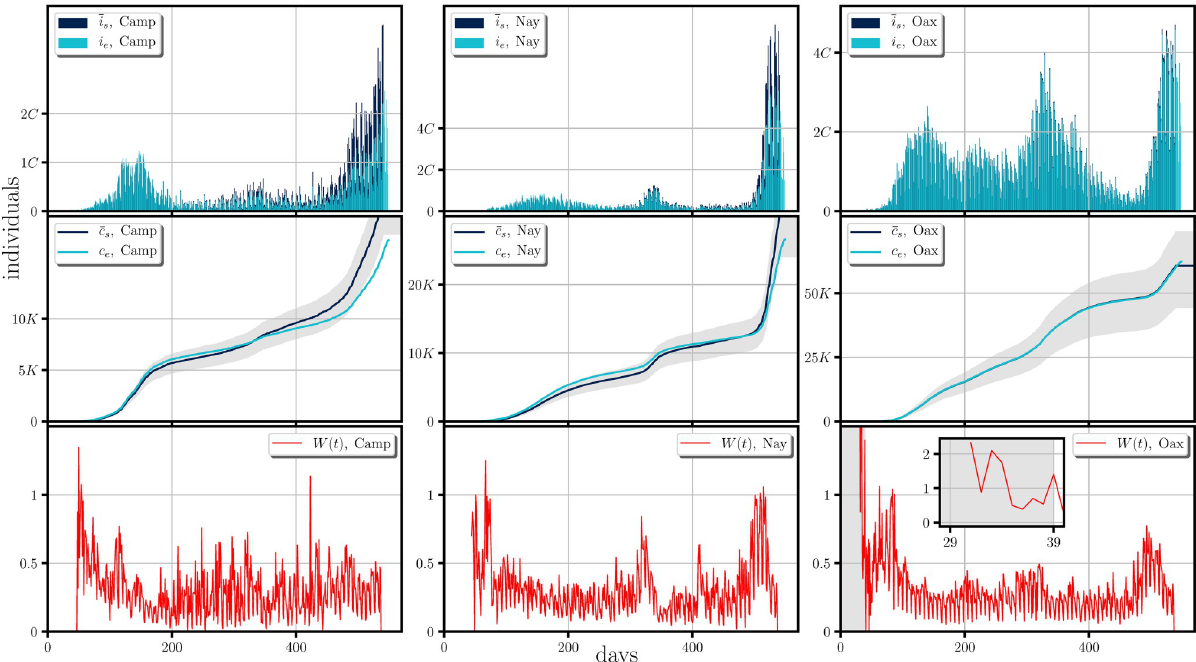
Fig 7. Comparison between the synthetic data generated by the stochastic model and real scenarios happening in some Mexican states and the form of their corresponding weight functions. The figure shows a comparison of the incidence (first row) and its cumulative (second row), between the synthetic data ( � i and � c ) generated by the stochastic model when averaged over 1000 trajectories to the real scenarios ( i s s Campeche(Camp), Nayarit(Nay) and Oaxaca(Oax). The shaded region for the cumulative of the incidence represents the 1st and the 3th quartil of the cumulative of the synthetic incidence generated randomly. The synthetic data was generated by employing the empirical estimation of the weight function (last row) obtained form Eq (16). The figure shows a period of roughly a year and a half of the spreading of the SARS-CoV-2 (from February 18th, 2020 to August 20th,